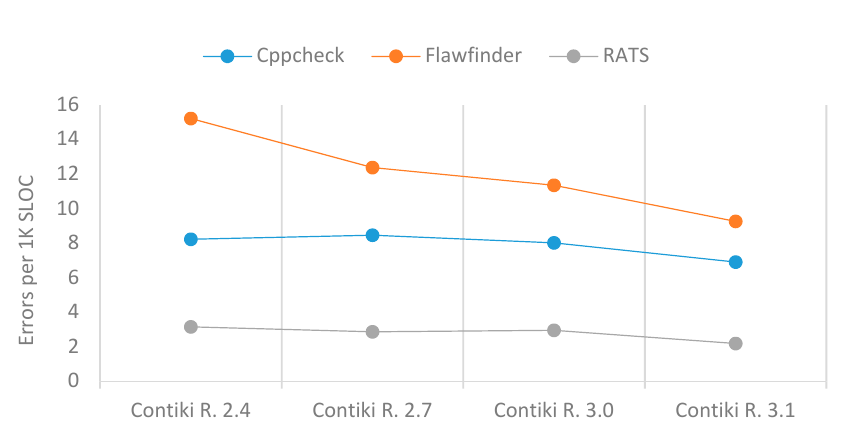
Table 6. Total errors and errors per 1K SLOC of